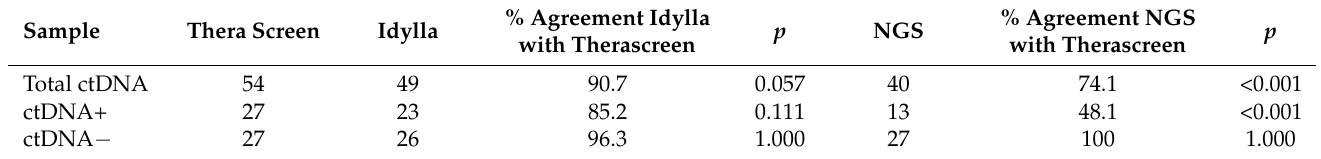
Table 4. Concordance rates between methods used to screen the 54 ctDNA samples.